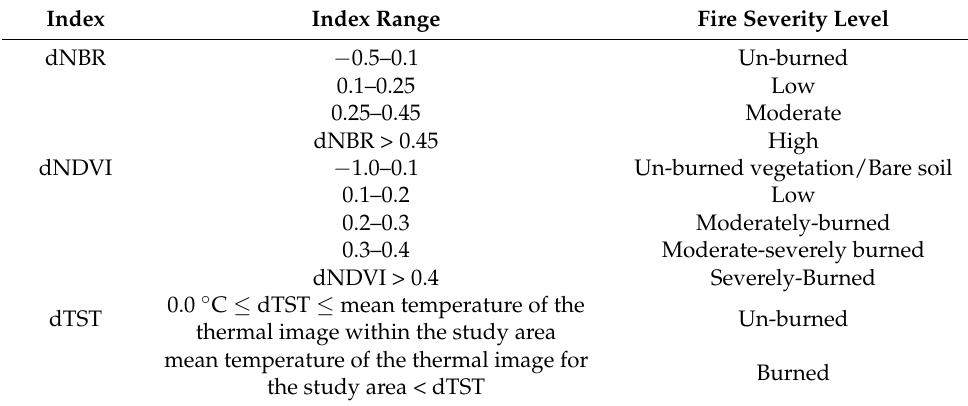
Table 1. Differenced Normalized Burn Ratio (dNBR) [31], Normalized Different Vegetation Index (dNDVI) and Thermal Surface Temperature